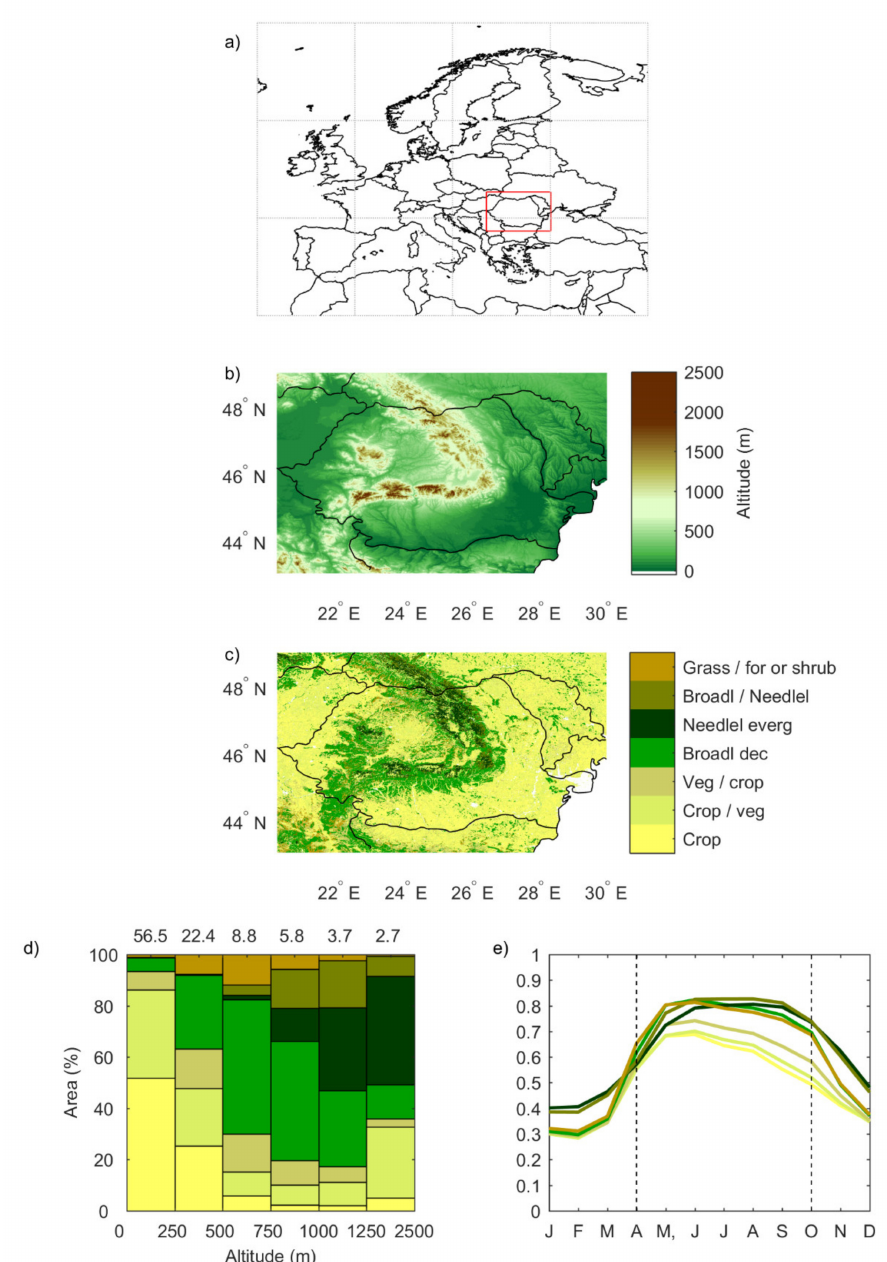
Figure 1. ( a ) Location of the study area; ( b ) elevation, as obtained by GLOBE project; ( c ) land cover classes, as identified by Globcover 2009; ( d ) area covered by each land cover class along the elevation range. Top axis shows the percentage area on each elevation interval, relative to the total land area; ( e ) median monthly NDVI (Normalized Di ff erence Vegetation Index) for each cover class, as obtained by SPOT